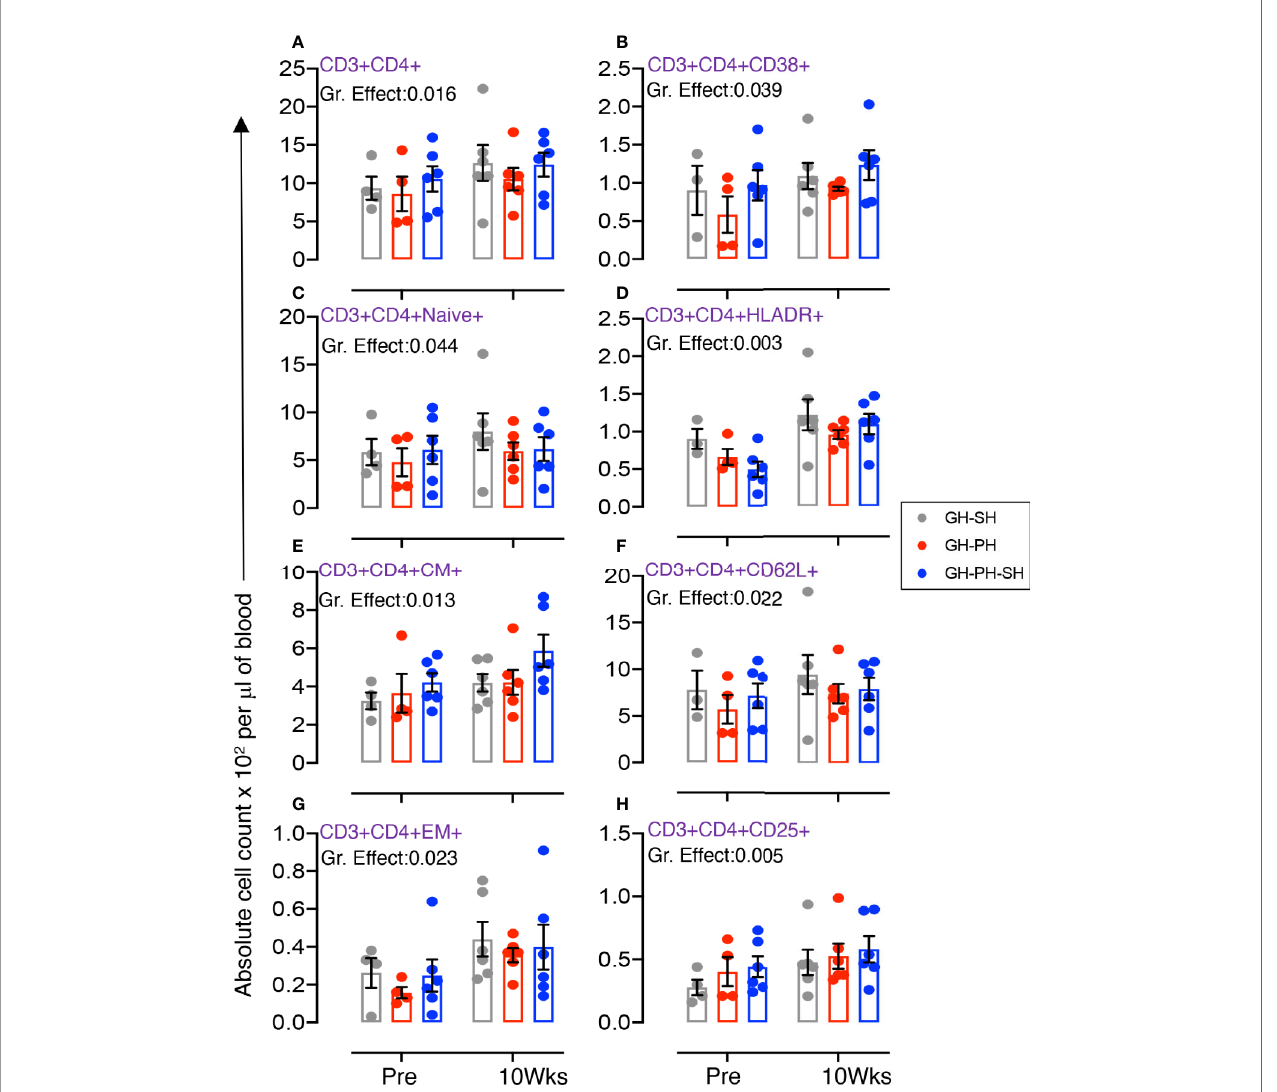
FIGURE 3 | Absolute count of peripheral blood CD4+ T cells and its subpopulation were shown for GH-SH, GH-PH and GH-PH-SH groups. A signi fi cant difference in total CD4+ (A) , activating CD4+CD38+ (B) , CD4+naïve+ (CD28+CD95 − ) (C) , late activating CD4+HLADR+ (D) , CD4+central memory (CM) (CD4+CD28+CD95+) (E) , traf fi cking CD4+CD62L+ (F) , CD4+effector memory (EM) (CD4+CD28 − CD95+) (G) , and regulatory CD4+CD25+ (H) cells was detected among groups across housing treatment time points. The X axis denotes pre- and post-separation housing time points and the Y axis denotes absolute counts. Individual values from each animal are shown as colored circles with bars showing mean ± standard error for each